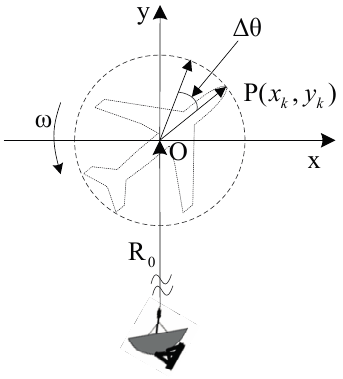
Figure 1. Geometry of turntable model